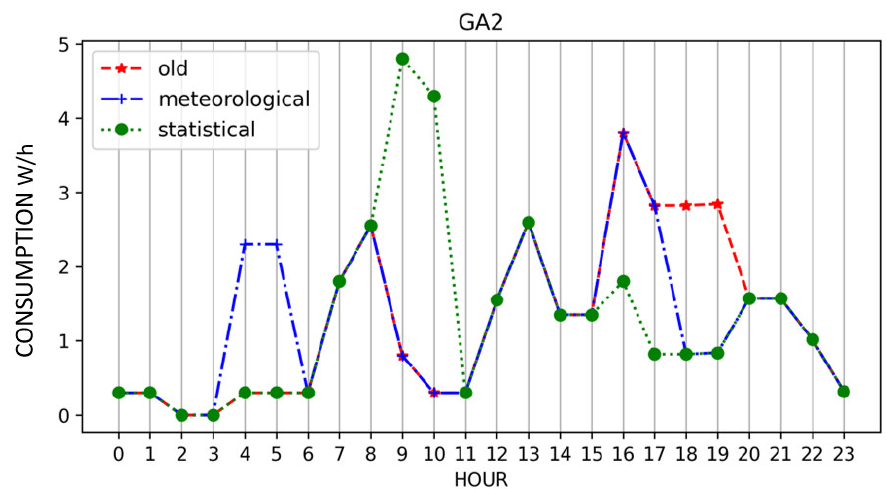
Figure 3. The optimized household appliance scheduling for the second user.